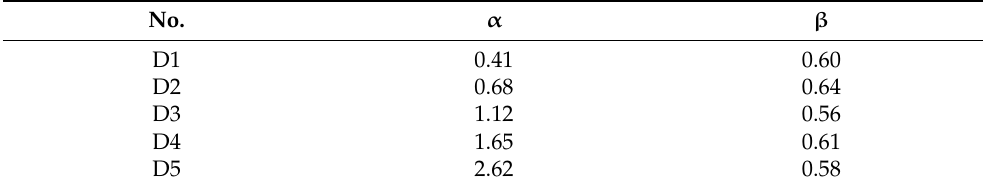
Figure 4. Impact force results of drop hammers with different shapes impacting the sand cushion. Table 3. First fitting